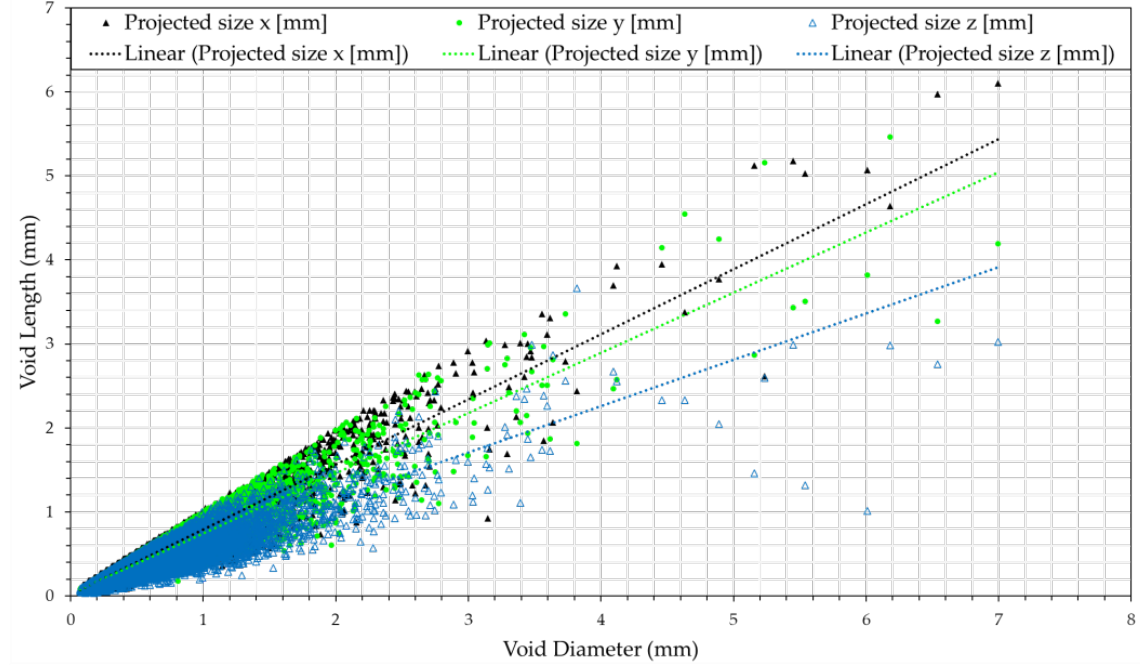
Figure 12. 3DCPOIT void topology from μ -CT scanning. The coefficients of determination (R 2 ) for x, y and z linear regression are 0.92, 0.91 and 0.86, respectively. Table 6. Normalised 3D voids for each configuration based on their regression model gradients. Normalisation performed with respect to the x-direction (printing direction).